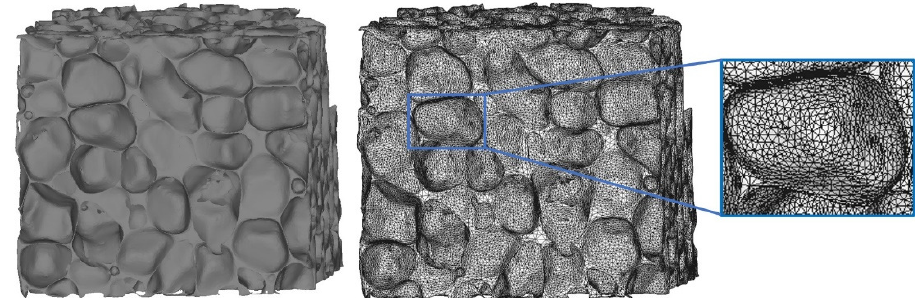
Figure 6. Finite element method (FEM) meshes of aluminum closed-cell foam (cross section: 10 mm × Figure 6. Finiteelementmethod(FEM)meshesofaluminumclosed-cellfoam(crosssection: 10mm × 10mm). 10 mm). Courtesy of Diogo Heitor, Universidade de Aveiro, Portugal. Courtesy of Diogo Heitor, Universidade de Aveiro,